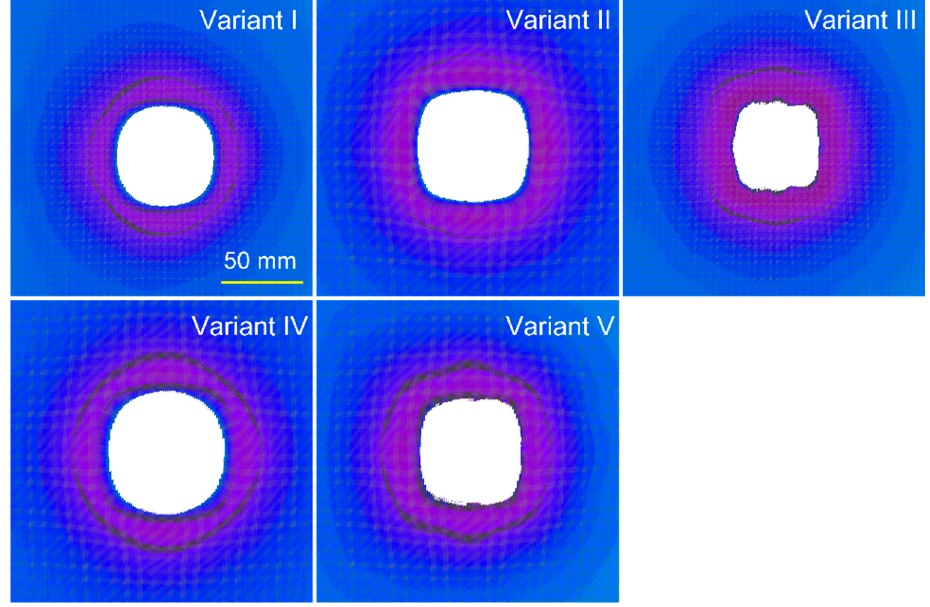
Figure 8. Inlet cavities at the zero level of the plasticine substrate when firing packages made in the assumed variants.